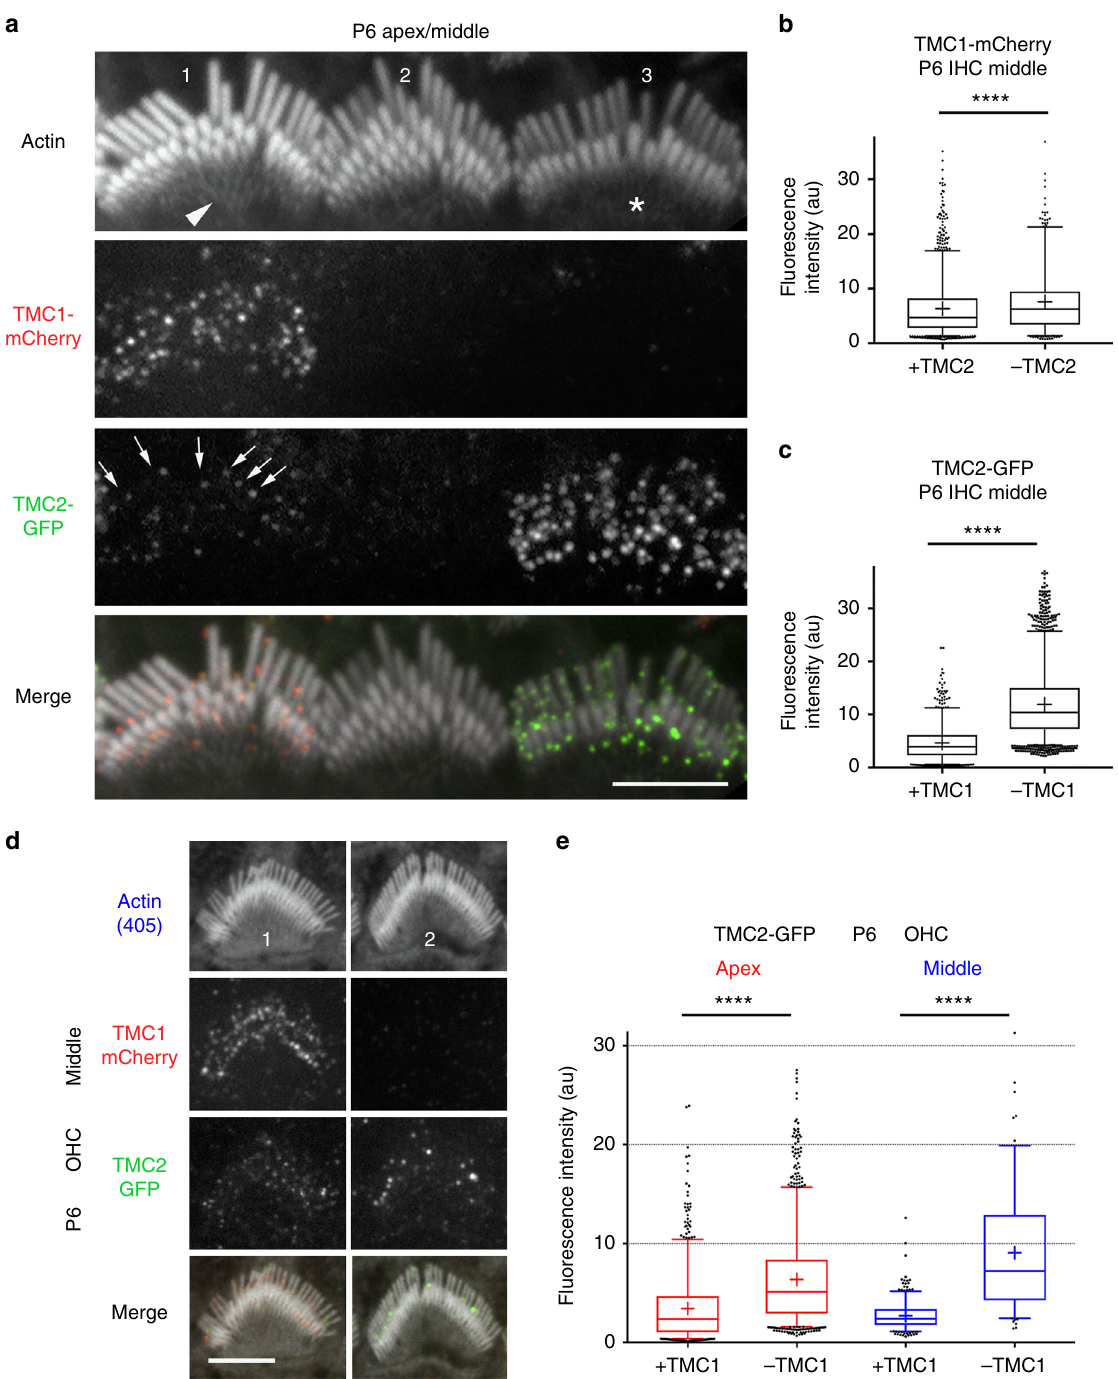
Fig. 9 TMC2-GFP levels in IHC and OHC stereocilia are in fl uenced by TMC1-mCherry levels. a Confocal image of three IHC stereociliary bundles (bundles 1 – 3) from a P6 transgenic mouse with a mosaic expression of TMC1-mCherry (second panel), and/or TMC2-GFP (third panel). Some cells do not express any transgene (e.g., bundle 2). Bottom panel, merge image of all three channels. TMC2-GFP levels are comparatively lower (arrows in bundle 1) in the presence of TMC1-mCherry than in the absence of TMC1-mCherry (bundle 3). Note that relative to normal bundle morphology when both TMC1-mCherry and TMC2-GFP are expressed (bundle 1), bundle morphology is immature, with multiple stereocilia rows, when both TMC1 and TMC2 are missing (bundle 2), and more developed when TMC2-GFP is more highly expressed in the absence of TMC1-mCherry. b Relative fl uorescence intensity of TMC1-mCherry puncta in IHC stereocilia at P6 in IHCs that express TMC2-GFP is slightly lower (6.4 ± 0.1 arbitrary units; N = 1315), compared with IHC that do not express TMC2-GFP (7.6 ± 0.3; N = 814). c Relative fl uorescence intensity of TMC2-GFP puncta in IHC stereocilia at P6 increases signi fi cantly in IHCs that do not express TMC1-mCherry (11.9 ± 1.4; N = 2134), compared with IHCs that do express TMC1-mCherry (4.7 ± 0.1; N = 814). d Confocal images of two OHC stereocilia bundles (#1 – 2) from cochlear middle turn from transgenic mice (P6) with a mosaic expression of TMC1-mCherry (second panel), and/or TMC2-GFP (third panel). Bottom panel — merged image of all three channels. Note that TMC2-GFP puncta are brighter in absence of TMC1-mCherry. e Plot of relative fl uorescence intensity of TMC2-GFP puncta in P6 OHCs at cochlear apex in presence (3.4 ± 1.2; N = 750) and absence (6.4 ± 1.3; N = 1252) of TMC1-mCherry; and at middle turns in presence (2.7 ± 0.1; N = 398) and absence (9.1 ± 0.5; N = 1151) of TMC1-mCherry. Scale bar = 5 µ m. Box plot: whiskers, 5 – 95 percentile; + , mean. ****, p -value < 0.0001 (Student ’ s t- test; all values expressed as mean ±